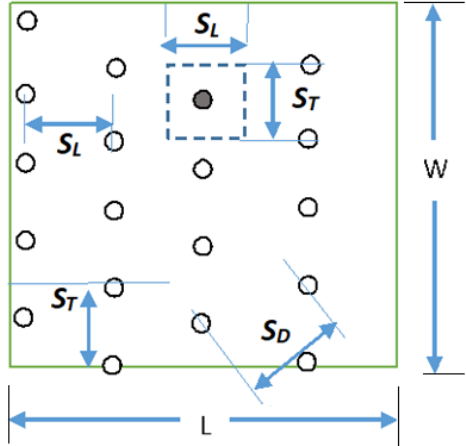
Figure 2. Top view of the proposed EPS model showing its length L and width W. The longitudinal, transverse, and diagonal pitches for the equilateral-triangle arrangement is also shown. The unit for all of these parameters is